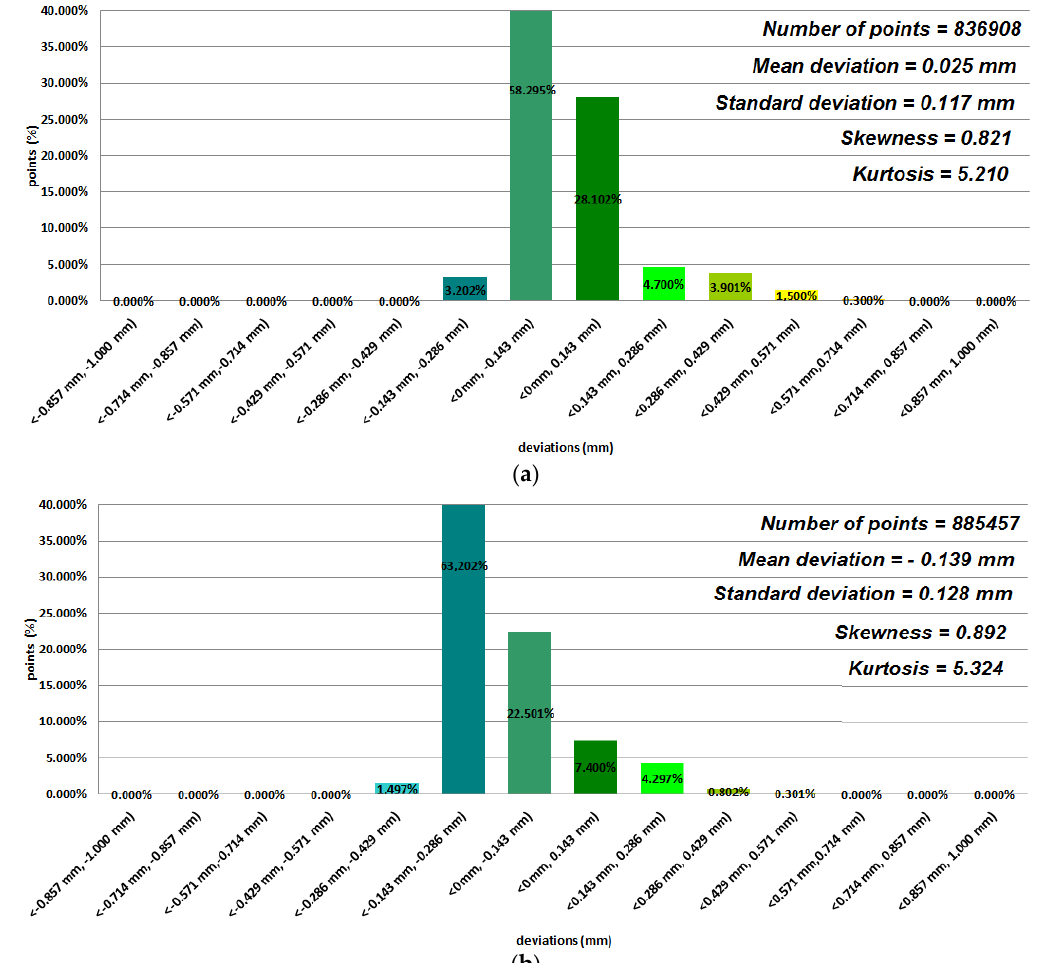
Figure 6. Histograms representing average results of the 12 mandible structures: ( a ) E-Model material; ( b ) Precimid 1170 material; ( c ) FullCure 830 material.